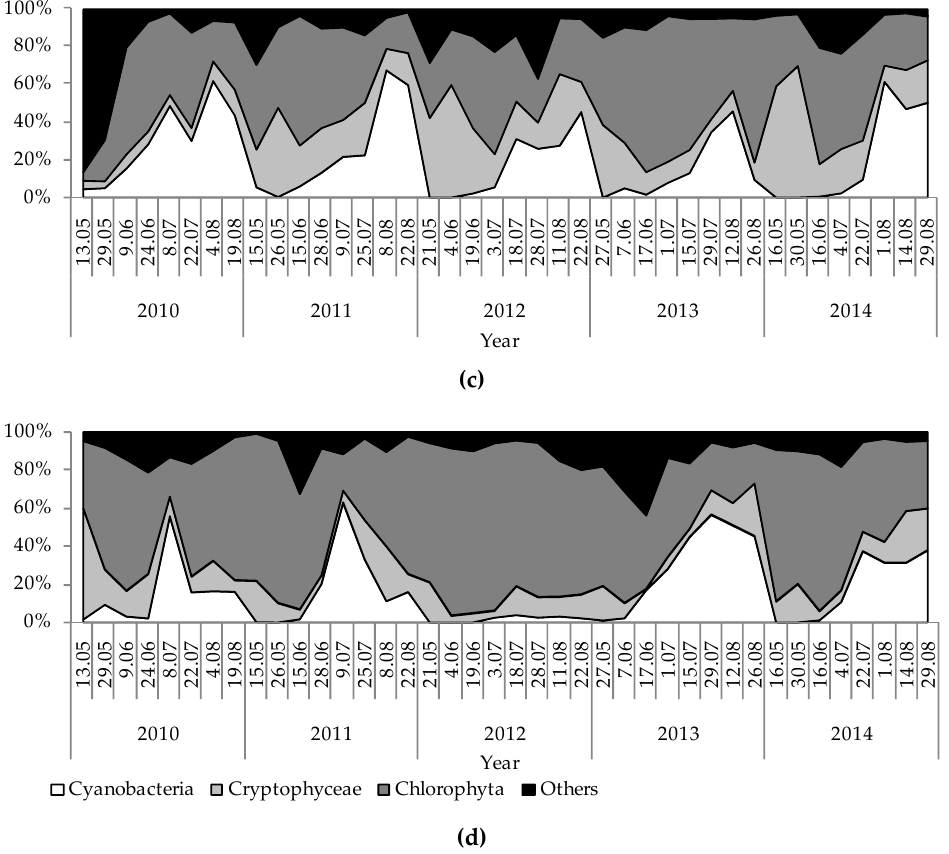
Figure 5. Temporal variation of percentage shares of phytoplankton groups based on biomass during the investigation period (2010–2014) in the studied lakes: ( a ) G Łę bokie; ( b ) Gumienek; ( c ) Czarne; ( d ) Ma ś luchowskie.